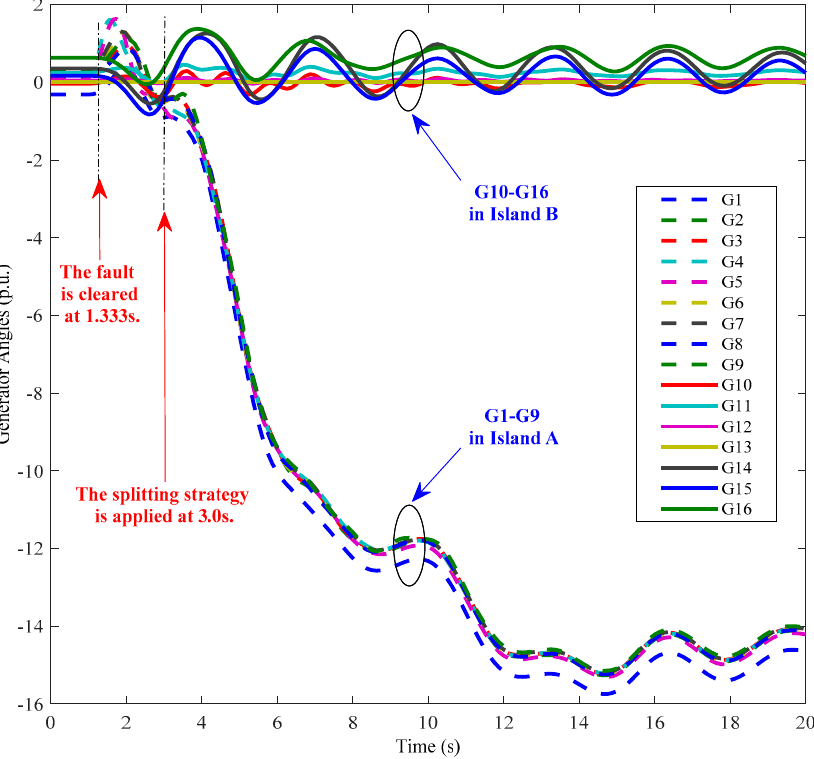
Figure 4. Generator angles of the power system after splitting within CIT.